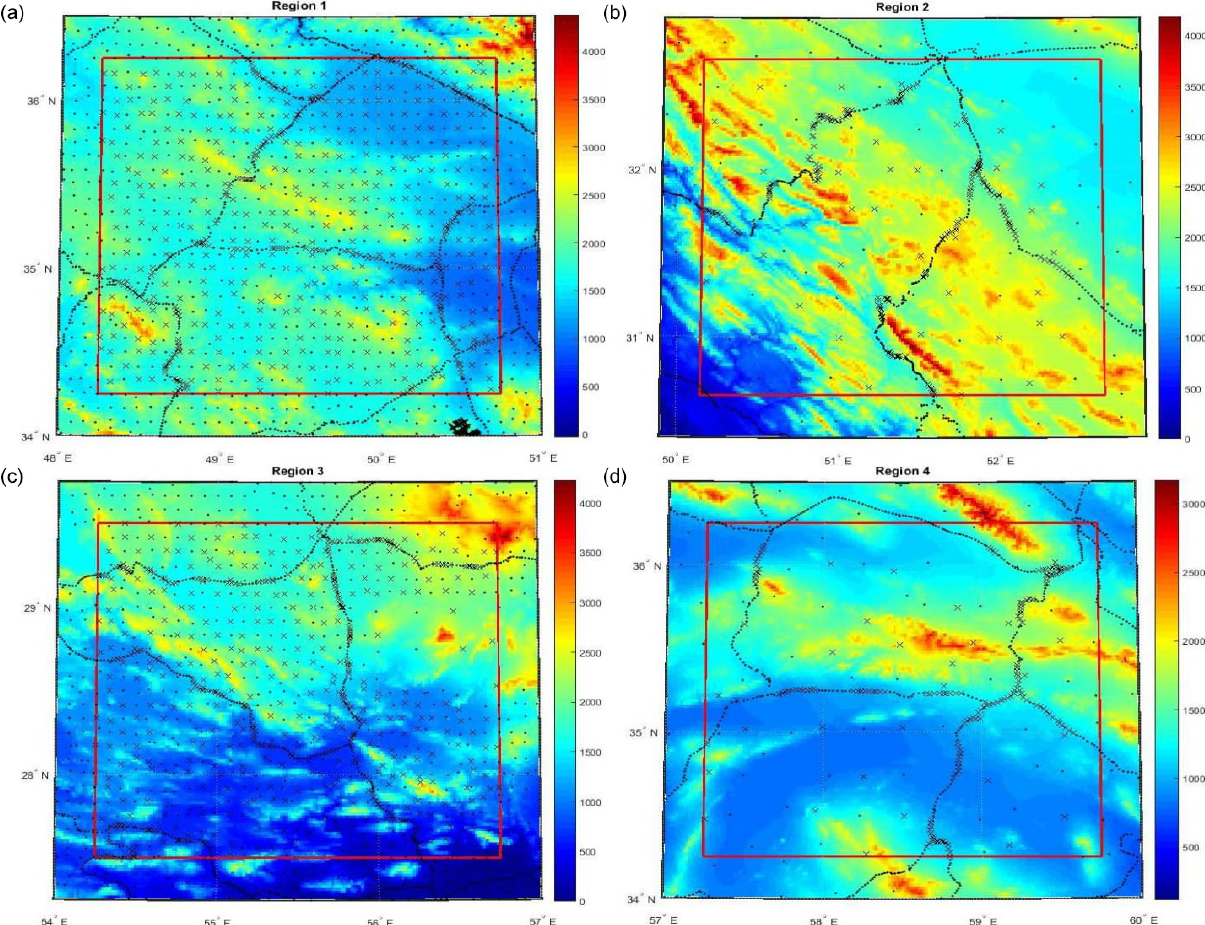
Figure 2. Divided data into observations (dots) and control points (crosses) in the regions (a) R1, (b) R2, (c) R3 and (d) R4. Topography as background (m). Table 6. Number of observations and control points before and after the data distribution refinement in each region. Region 1 2 3 4 Refinement Before After All data 2062 1148 818 Observation 1499 235